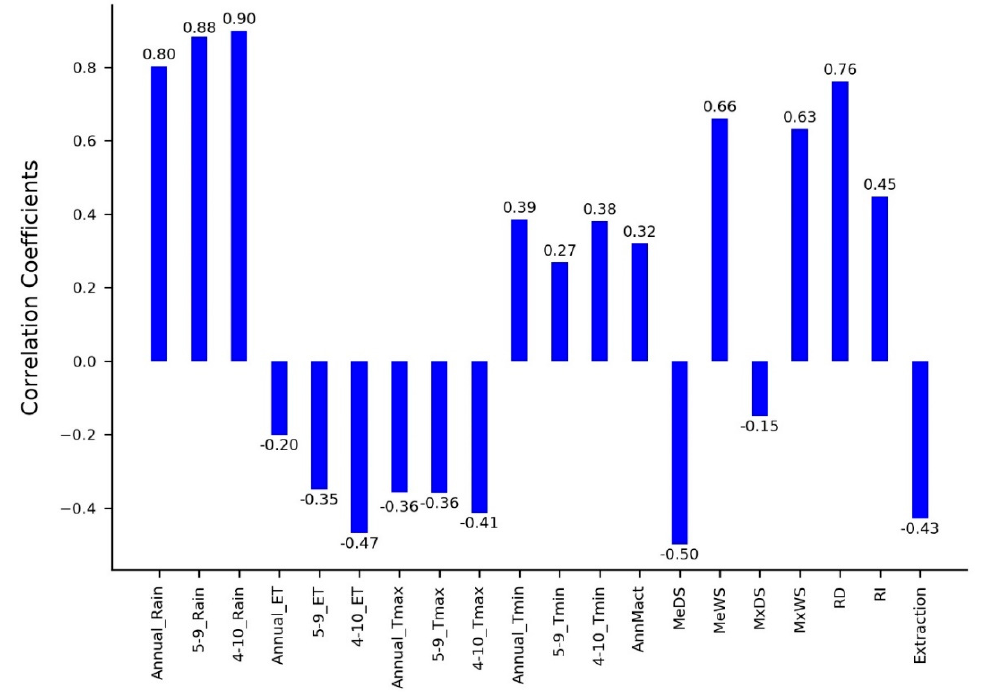
Figure 4. Correlation coefficients between regional groundwater recharge and influential predictors.